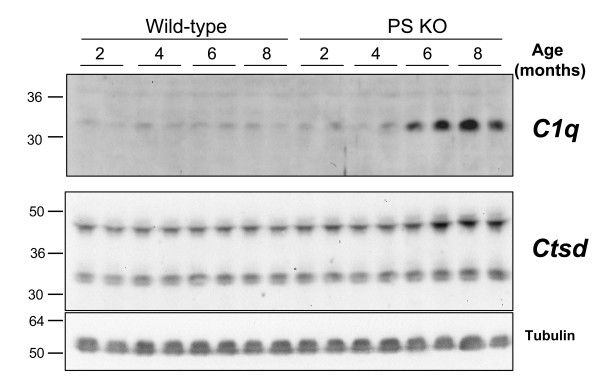
Age-dependent upregulation of C1q and Ctsd in PS knockout mice. The same nitrocellulose membrane was re-probed for Ctsd, C1q, and Tubulin. Note a progressive, age-dependent upregulation of C1q and Ctsd in the KO mice but not the matched wild-type controls. Tubulin was used as a loading control. Molecular weights of Ctsd species correlate best to active intermediate (48 kD) and mature heavy chain (34 kD).